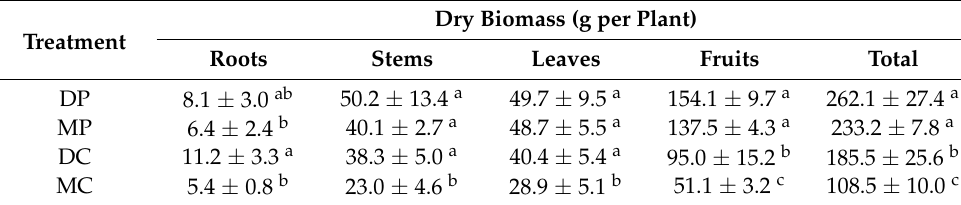
Table 3. Effect of digested pig slurry on plant dry biomass.